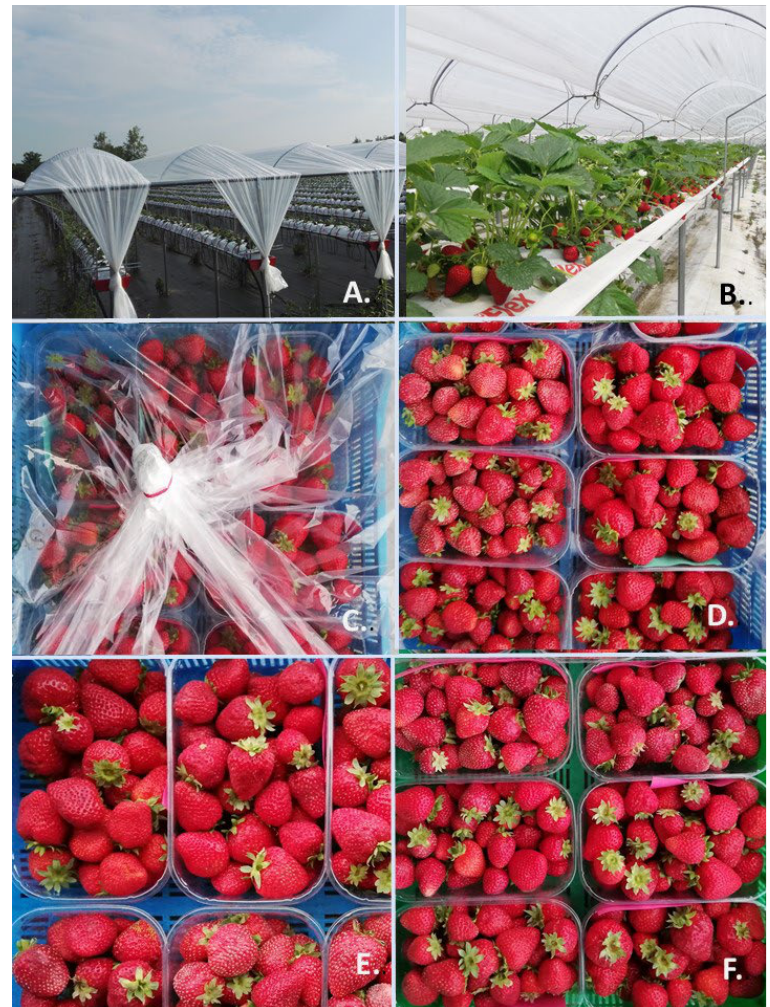
Figure 1. Strawberries cv. ‘San Andreas’. ( A , B )—Strawberry grown in technology in the described experiment, ( C )—Storing strawberries in MAP bags, ( D )—cv. ‘San Andreas’ after one week of storage in MAP bags, ( E )—cv. ‘San Andreas’ after one week of storage in an air atmosphere, ( F )—cv. ‘San Andreas’ after one week of controlled atmosphere storage.